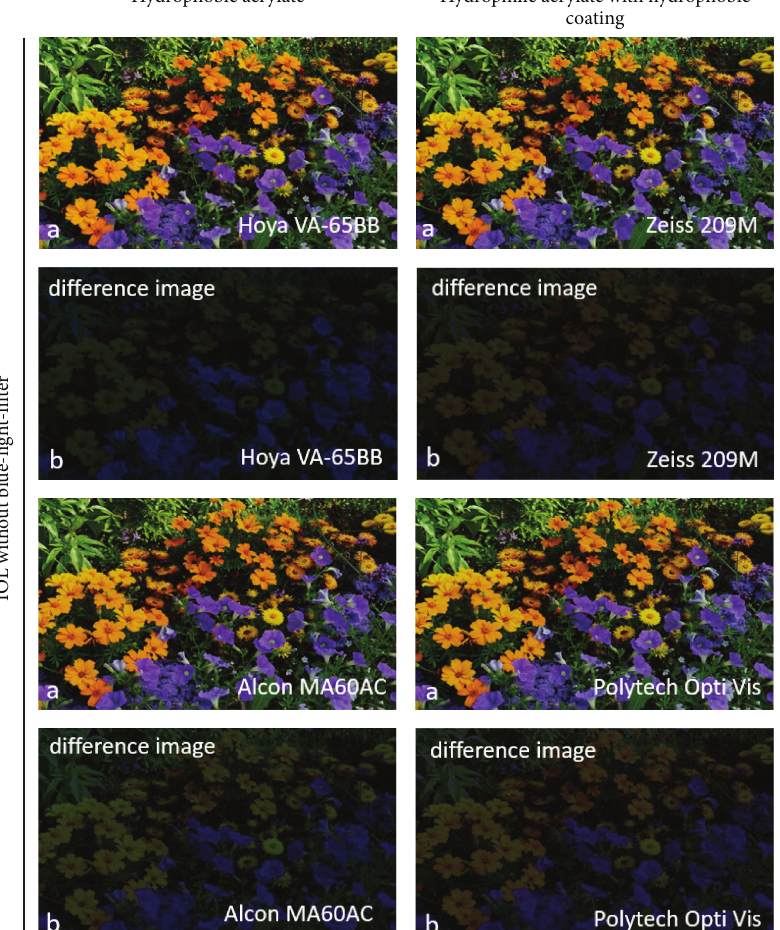
Figure 9: (a) Influence of the specific transmittance curves on the reference image for hydrophobic IOL materials and hydrophilic IOL materials with a hydrophobic coating, in each case without blue-light filter. (b) Difference between reference image and the image affected by a specific transmittance curve for each IOL (for enhanced visualization, the brightness value was increased by a factor